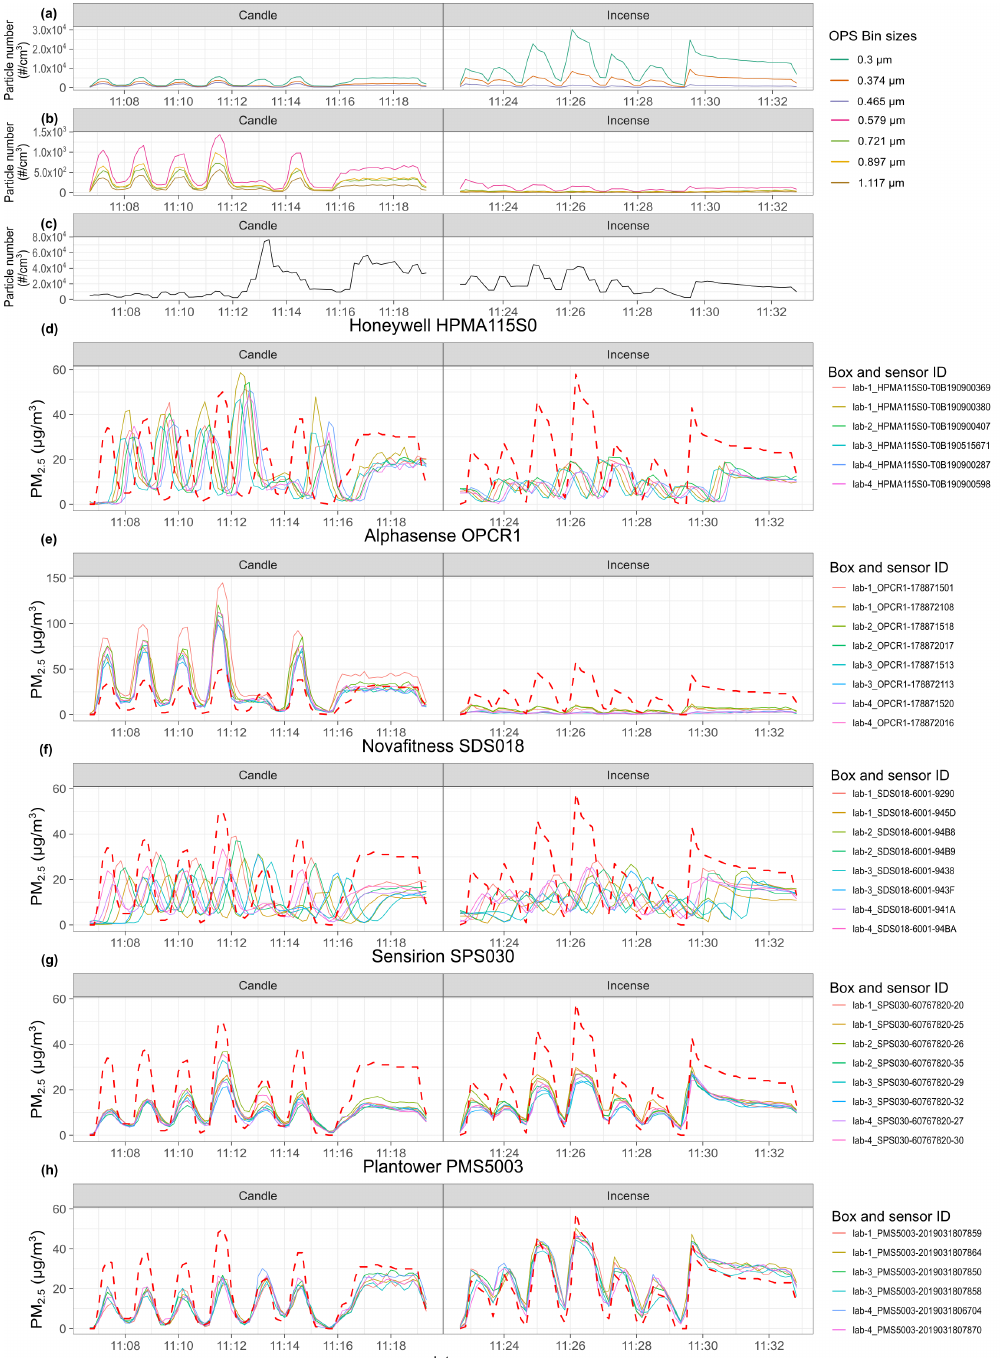
Figure A12. Time series of experiment 4. From top to bottom: ( a , b ) TSI 3330 OPS Bin size distribution; ( c ) Nanotracer ultrafine particles number concentration #1/cm 3 ; ( d – h ) PM 2.5 of the sensors for each model of sensor, against DustTrak (red dotted line). The sensors are named according to the box they are placed in and their serial